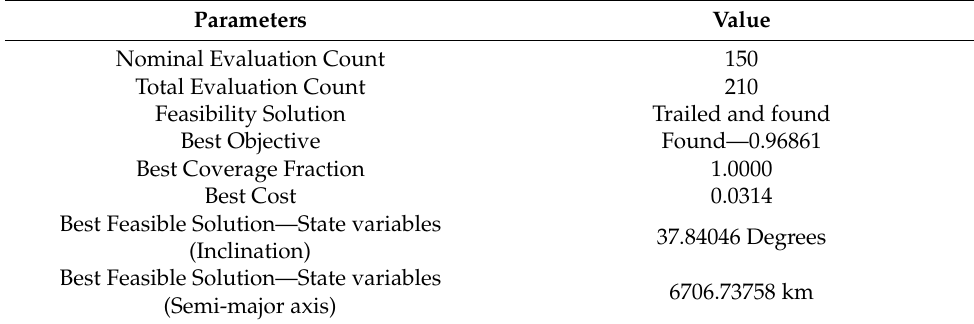
Table 2. Best solution for full coverage of small satellite constellation with the ipopt optimizer.